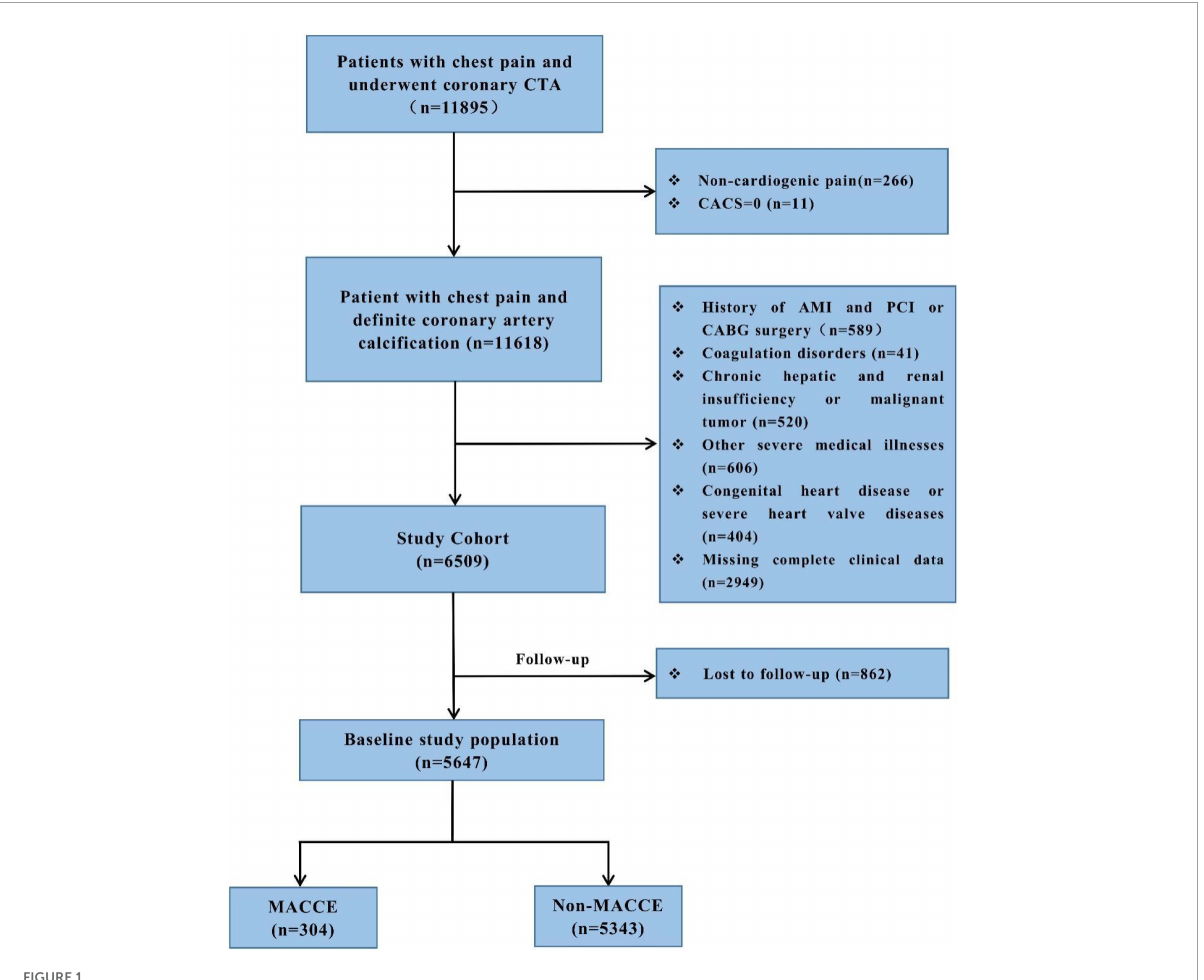
FIGURE1 Flow diagram of this